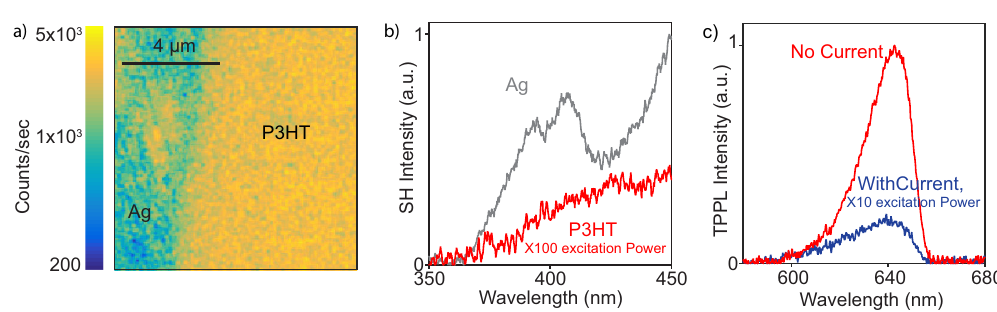
Figure 2. Non-linear photoluminescence. ( a ) TPPL spatial map at the interface between Ag and P3HT. ( b ) SH spectrum from the Ag electrode. The double peak in the spectrum is likely due to a non perfectly compressed pulse, as explained in ref. 20. In the same wavelength range optical signal from P3HT can only be detected upon two orders of magnitude increase in the excitation power. ( c ) Two photon photoluminescence spectrum from P3HT polymer with no current (red curve) and with current (blue curve) applied. The spectra are cut at 670 nm by the short pass filter used in the measurement. The application of a current strongly quenches the TPPL